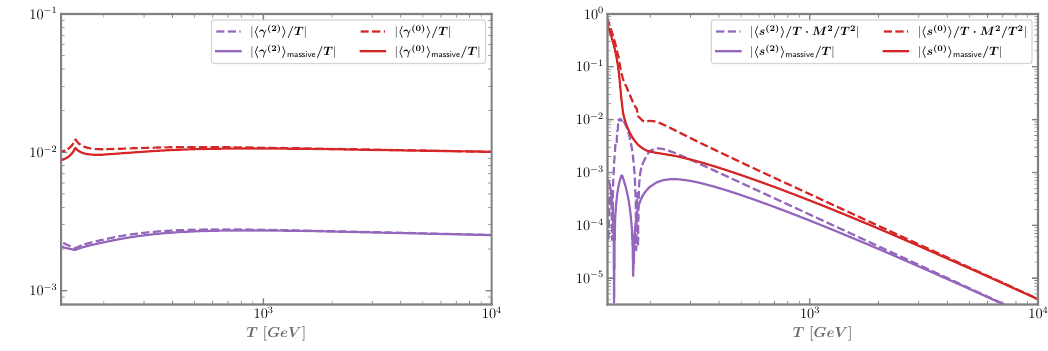
Figure 3 . Effective interactions rates entering the kinetic equation including (excluding) non- relativistic corrections in bold (dashed). The effect in the LNC case (left) is negligible whereas in the LNV case (right) the effective rate contribution can change by O (1 − 10) . We omit the γ 1 and s 1 rates as they can be derived from the shown results via eq.